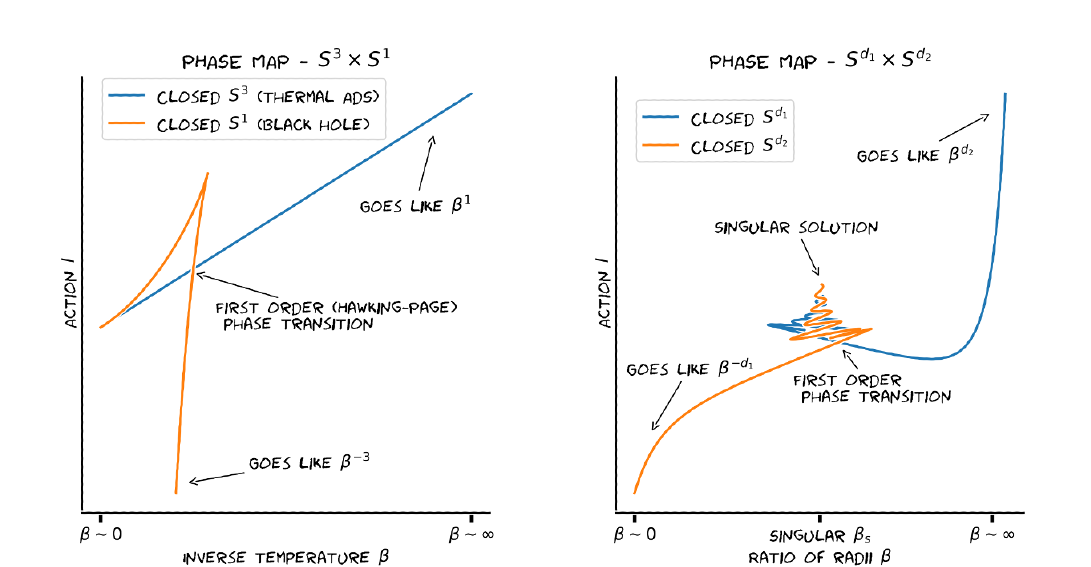
Figure 1 . Schematic plots of the Euclidean action I as a function of the ratio (cid:12) between the two radii. On the left, for the Hawking-Page case S 3 (cid:2) S 1 , with (cid:12) = R high-dimensional spheres S d 1 (cid:2) S d 2 ( d 1 ; d 2 (cid:21) 2, d 1 + d 2 < 9), with (cid:12) = R results do not (cid:12)x the sign of I in the asymptotic regions, we took the signs from the numerical results. As we note below (section 5 and section 6) these signs are correct for d 1 > d 2 . For d 1 = d 2 the sign of I in the two asymptotic regions is equal and is